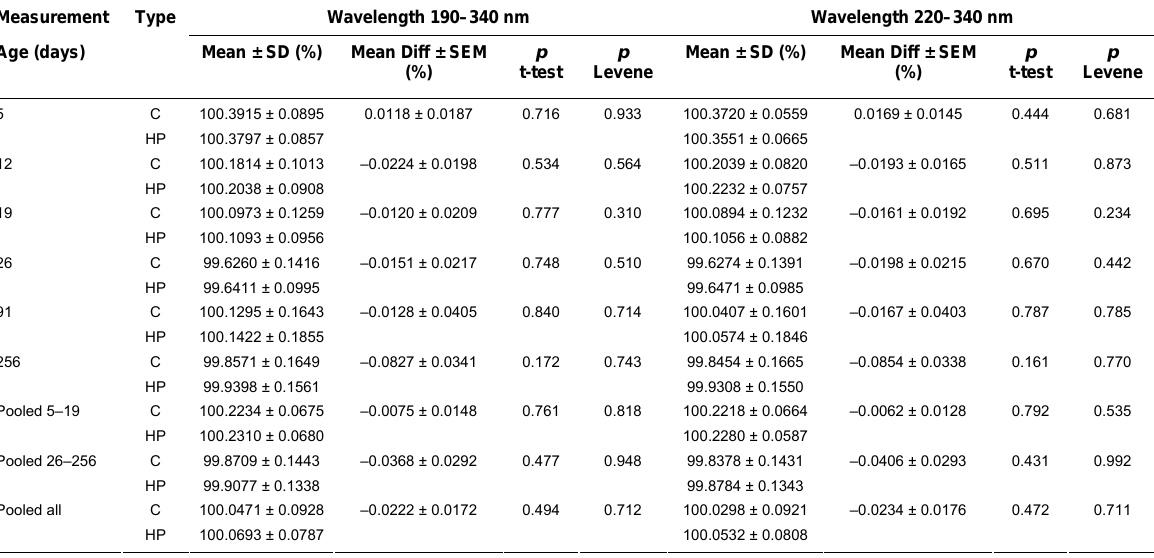
Homeopathic Preparations and Controls without 8 Exposure to External